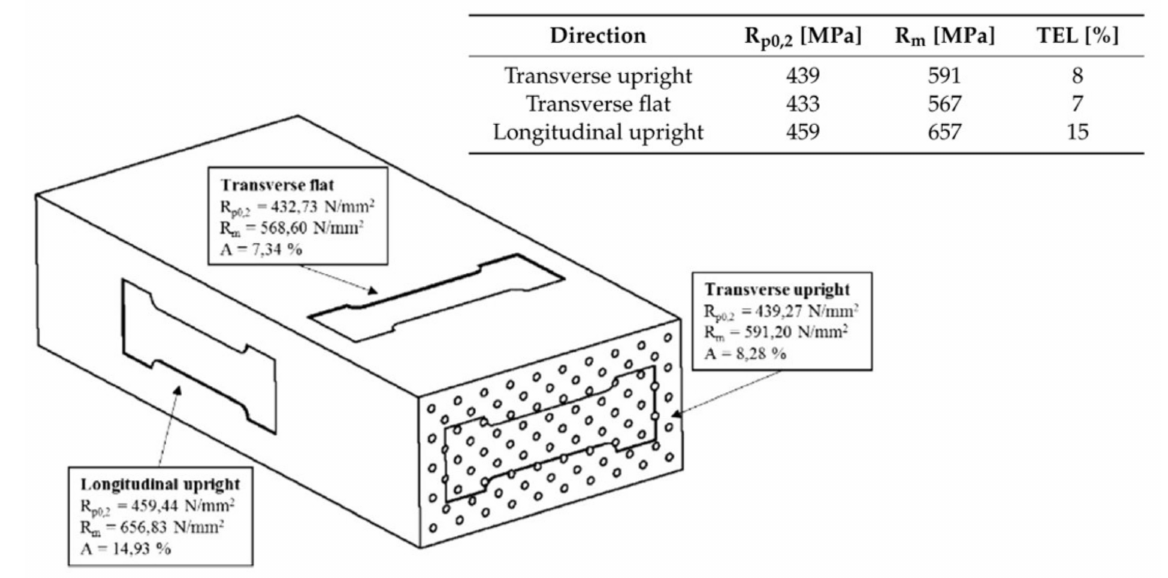
Figure 32. Strength of multi-material system of HSLA steel and FeNi36